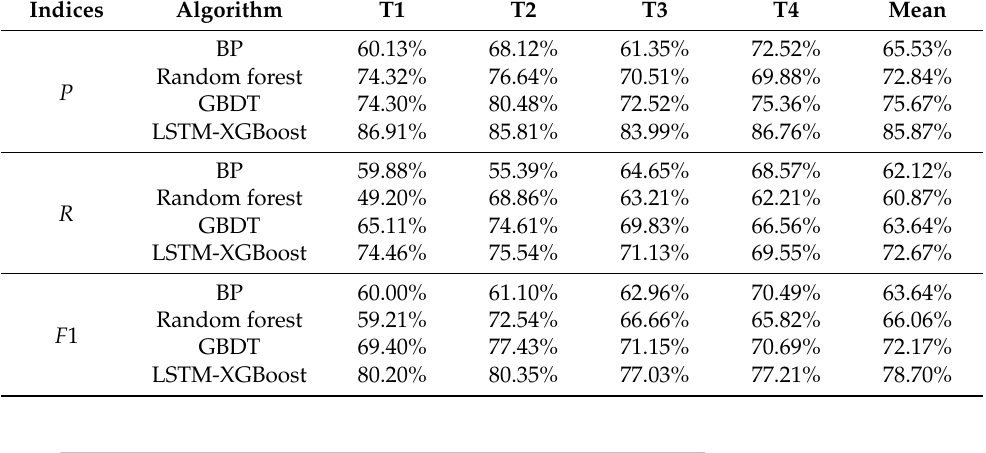
Table 8. Performance of short-term heavy overload prediction of each algorithm.